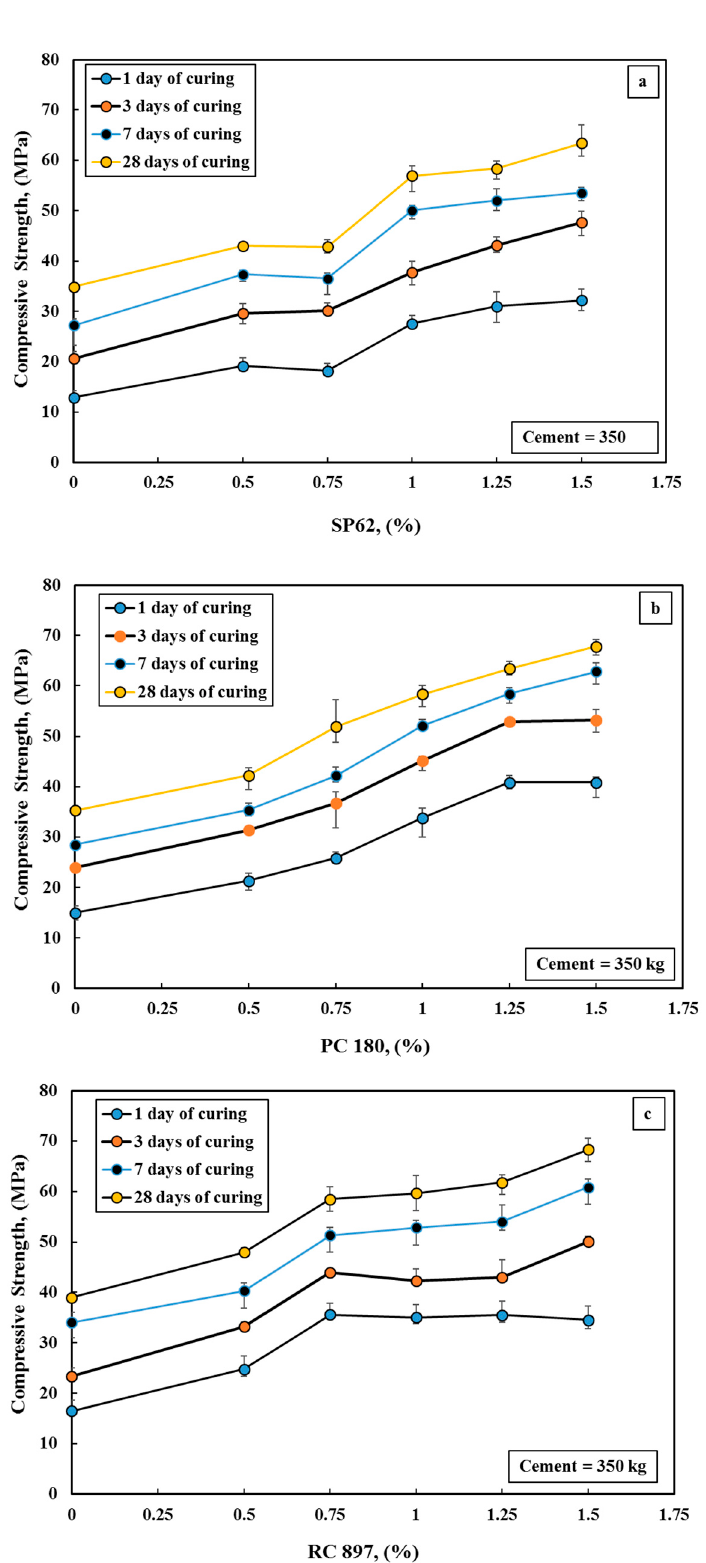
Figure 3. Additives’ impact on the concrete compressive strength using 300 kg cement ( a ) SP62, ( b ) PC 180, and ( c ) RC 897.